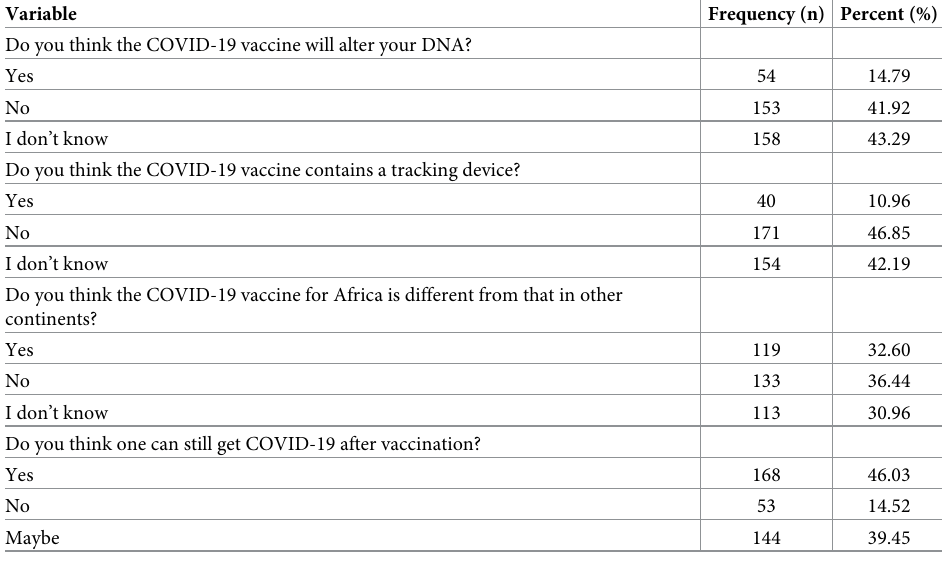
Table 6. Myths and socio-cultural perceptions against the vaccines (n = 365).